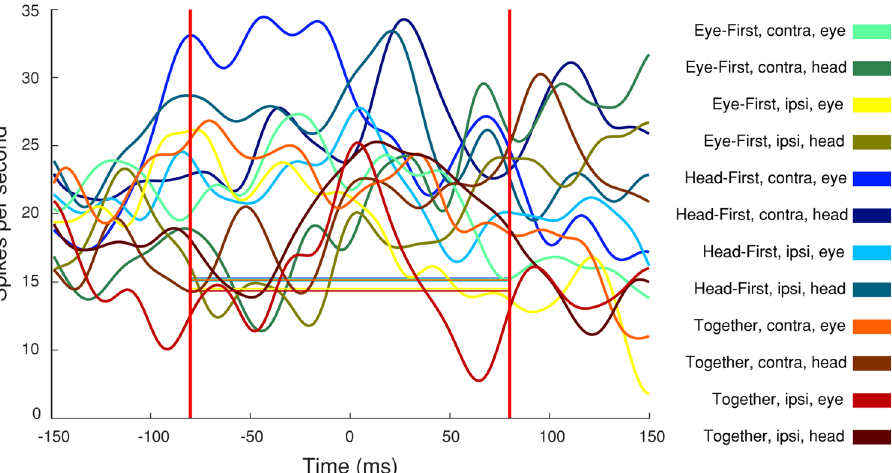
Figure 3. Timecourse of neural activity for an example PMv neuron. Trial-averaged firing rates for each of the 12 conditions are plotted as a function of time. The horizontal lines illustrate the average baseline activity for each condition, against which significance was determined in the epoch between the two vertical lines. Many baseline traces overlap, thus not all are detectable in the figure. No clear tuning across the 12 categories is identifiable in the firing rates of the neuron. The category associated with each color is shown on the right. The three pieces of information indicate trial-type, direction of movement being plotted, and the movement whose onset occurs at time 0. For example, “Eye-First, contra, head” category associated with the dark green color refers to the activity associated around the onset of a contraversive head movement in the eye-first task. This color-category designation is followed in subsequent